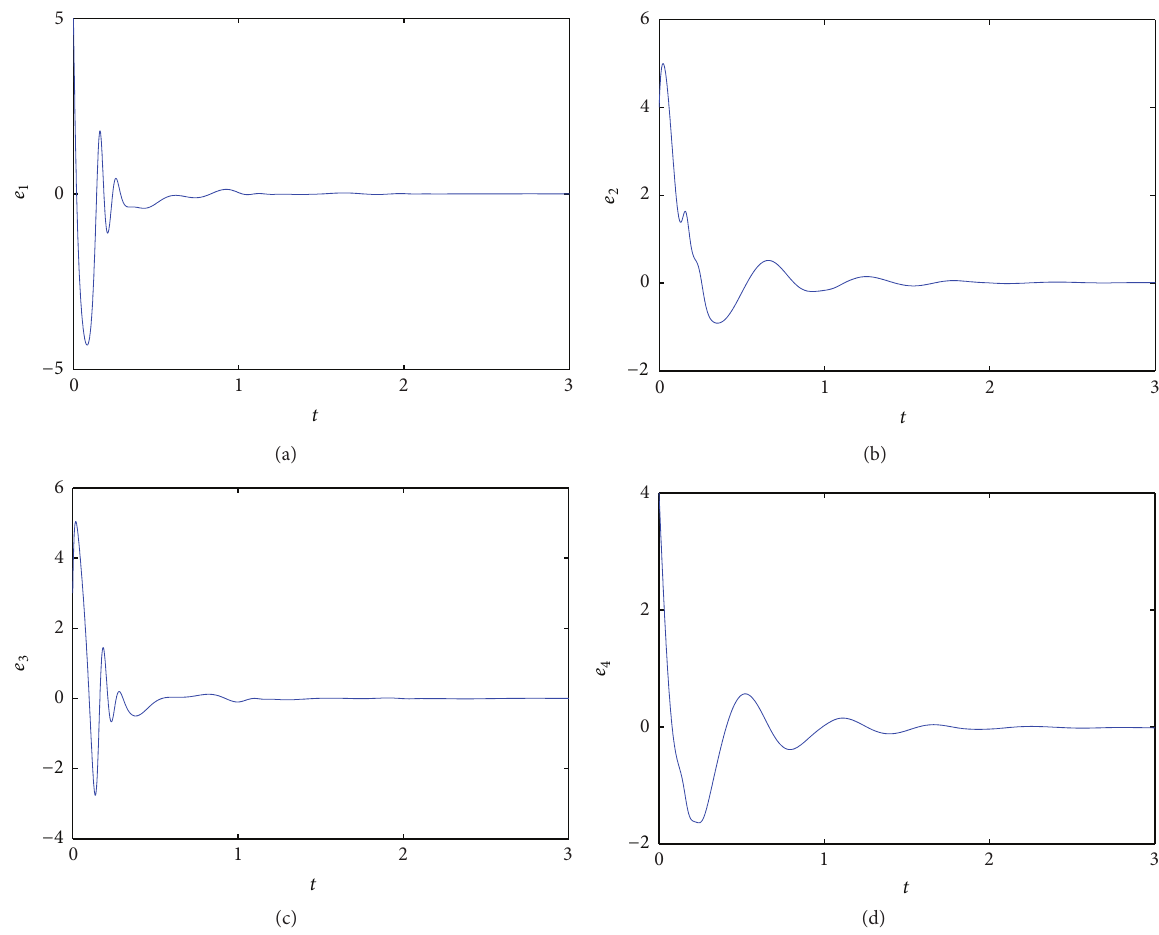
Figure 3: The synchronization errors between the drive systems (1) and the response system